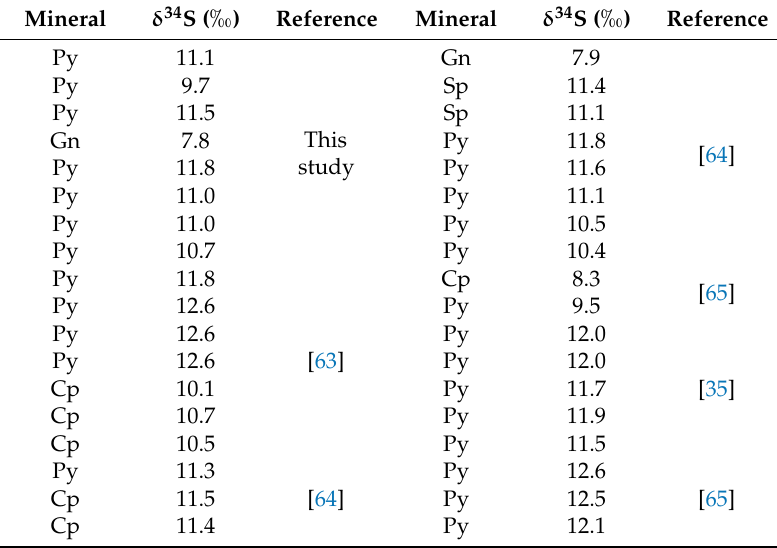
Table 4. Sulfur isotope analyses in the Sanshandao gold